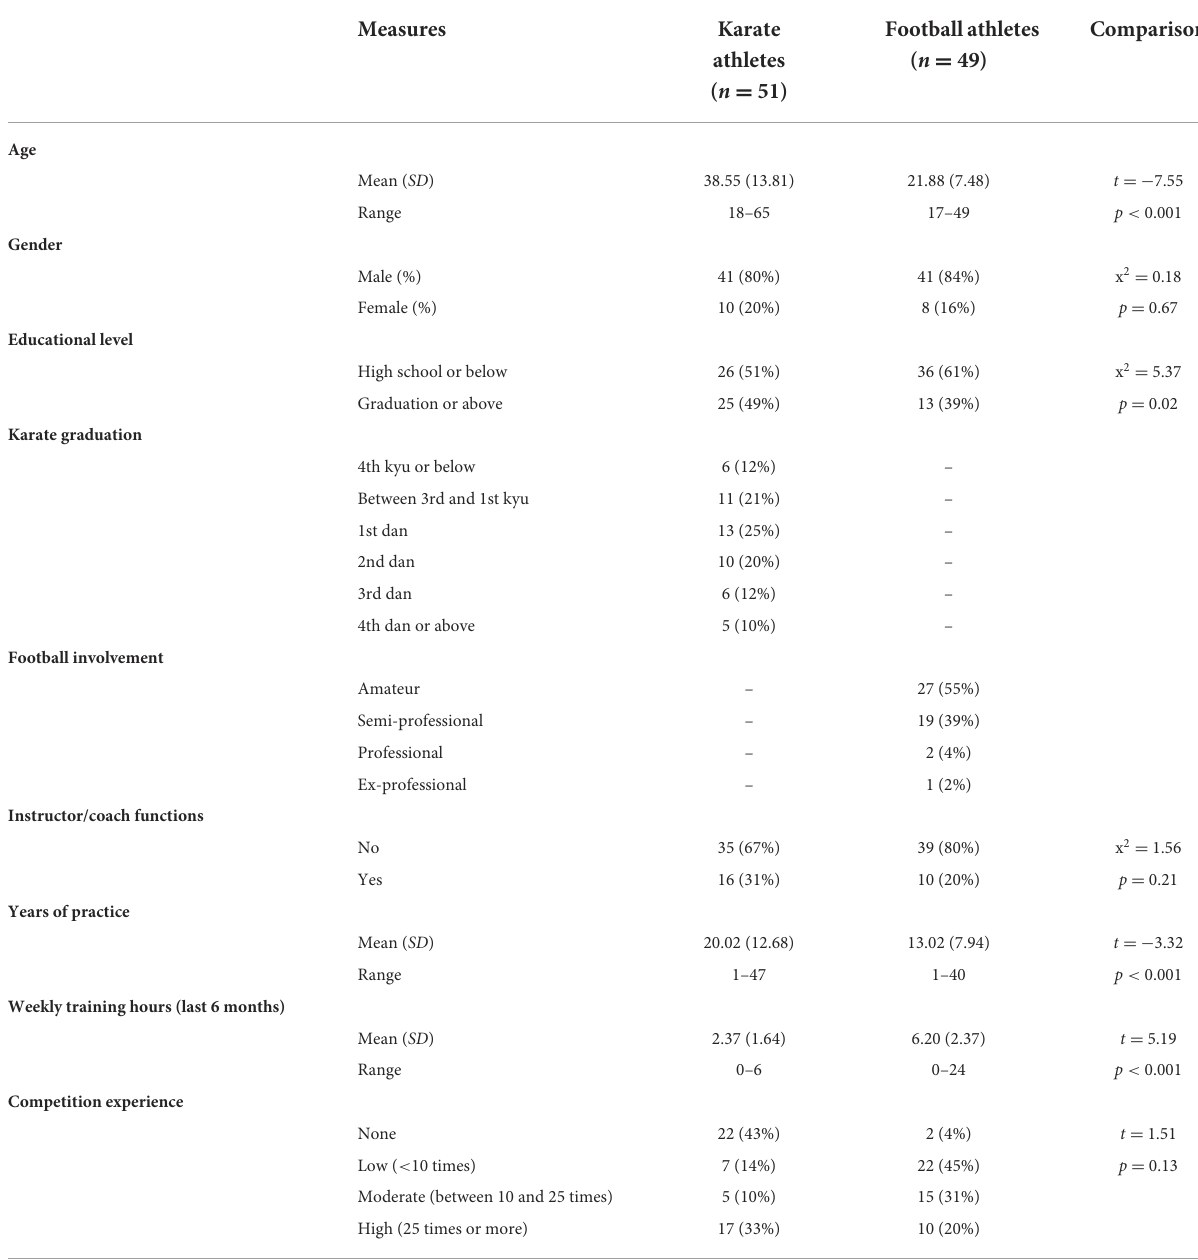
TABLE 1 Characterization and comparison of the karate and football